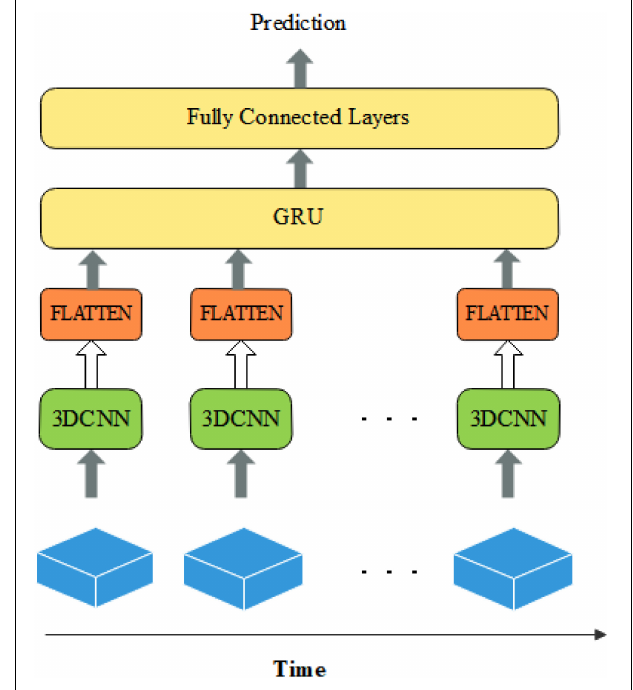
FIGURE 1 | The structure of the CNNG